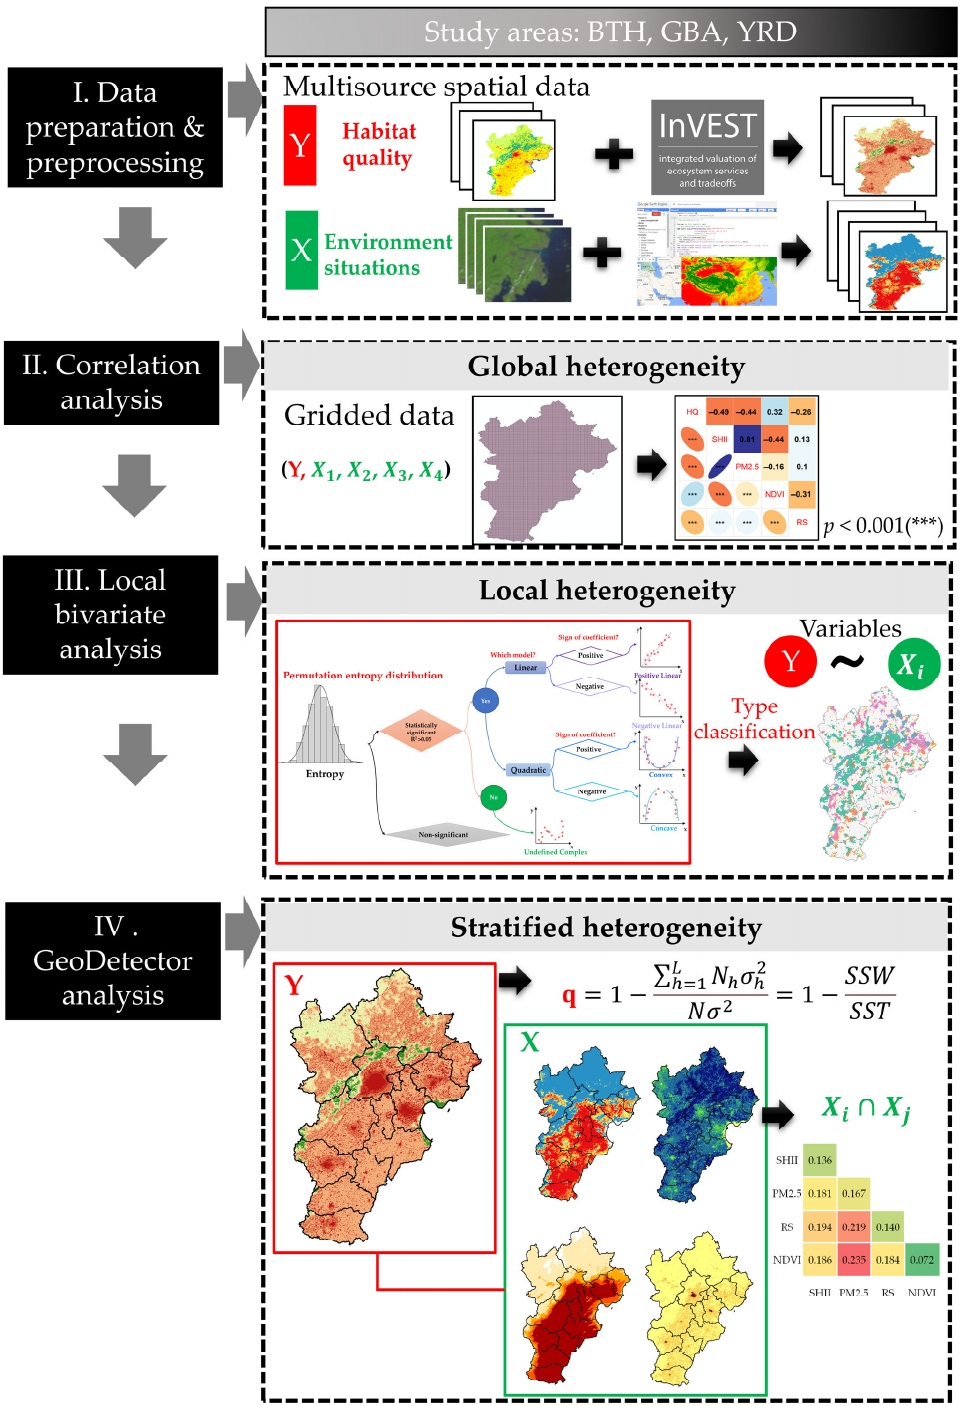
Figure 2. Overall research framework. Note: InVEST logo image sources from the website (https: //naturalcapitalproject.stanford.edu/software/invest (accessed on 30 November